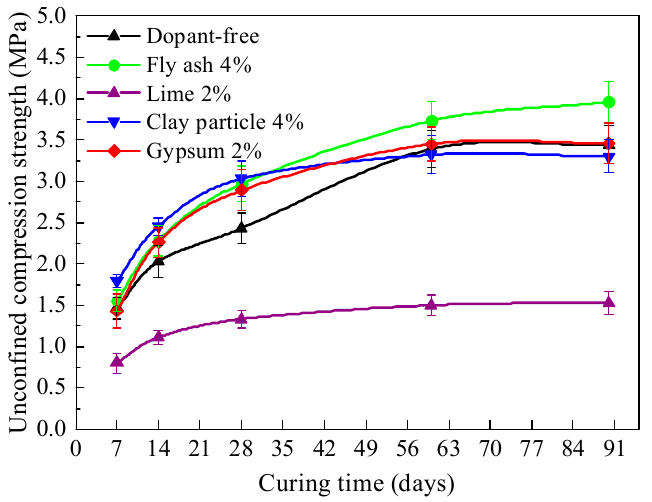
Figure 4. Curve of unconfined compressive strength with different replacement ratios of the additives.